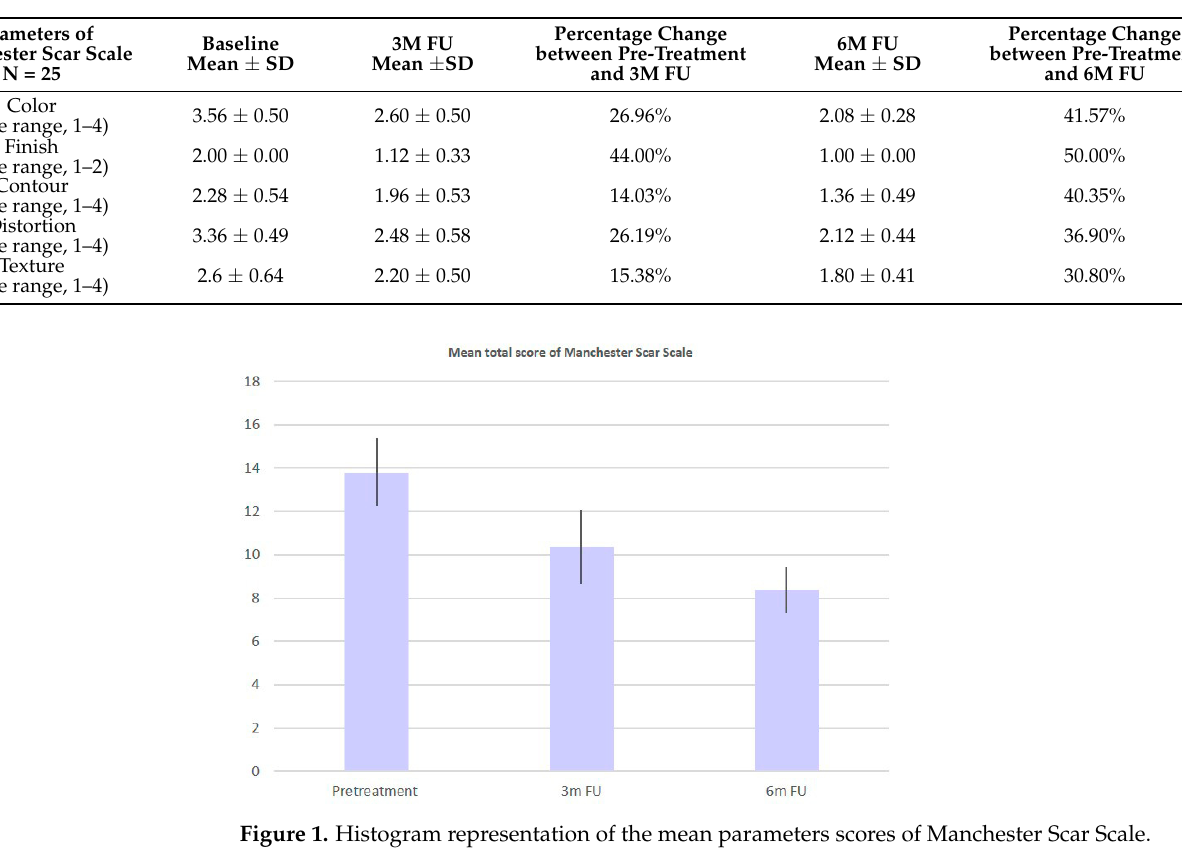
Table 1. Parameters of Manchester Scar Scale and mean scores related to each parameter at 3M FU and 6M FU.